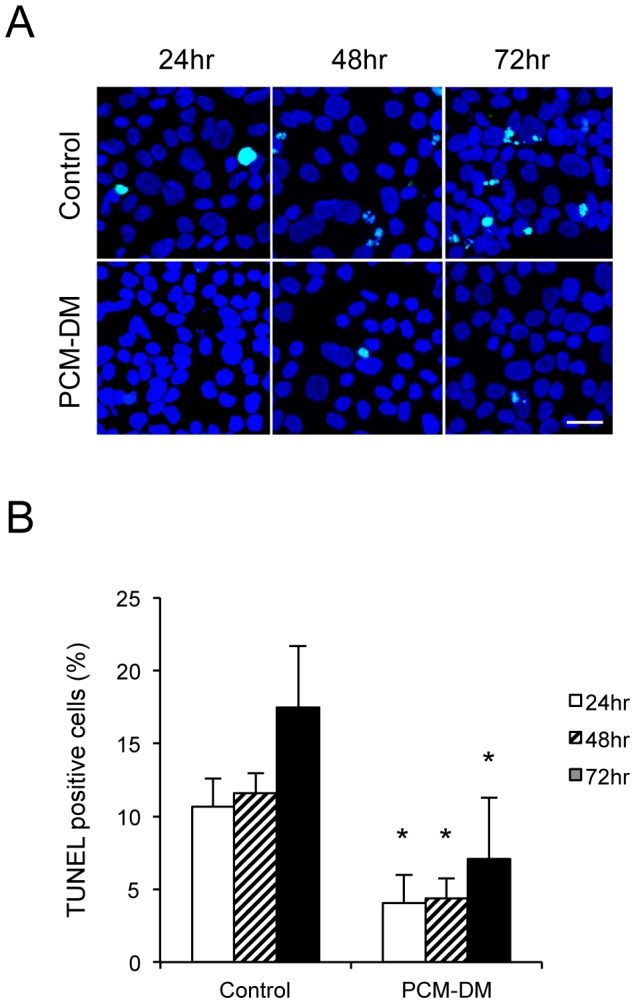
Antiapoptotic effect of PCM-DM.(A) To evaluate the effect of PCM-DM on the apoptosis of MCECs, serum was removed from the culture medium to induce apoptosis. TUNEL staining was performed to evaluate DNA fragmentation during apoptosis after 24, 48, and 72 h. Scale bar: 50 µm. (B) The percentages of TUNEL-positive apoptotic cells were evaluated (n = 3). The experiment was performed in duplicate. *p<0.01.